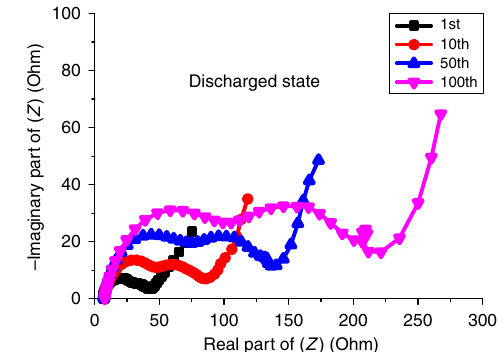
Figure 7 | AC impedance spectra. AC impedance of the Li(V 0.5 Ti 0.5 )S 2 / electrolyte interface collected at the end of the 1st, 10th,50th and 100th cycles using